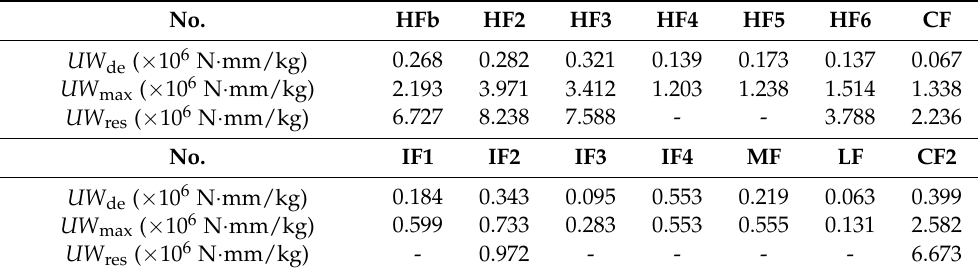
Table 8. The pull-out works of per unit weight steel